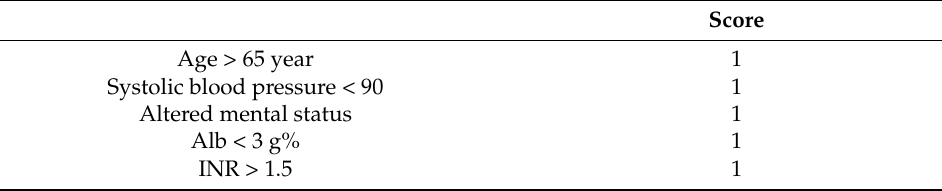
Table 5. AIM65 score [7].